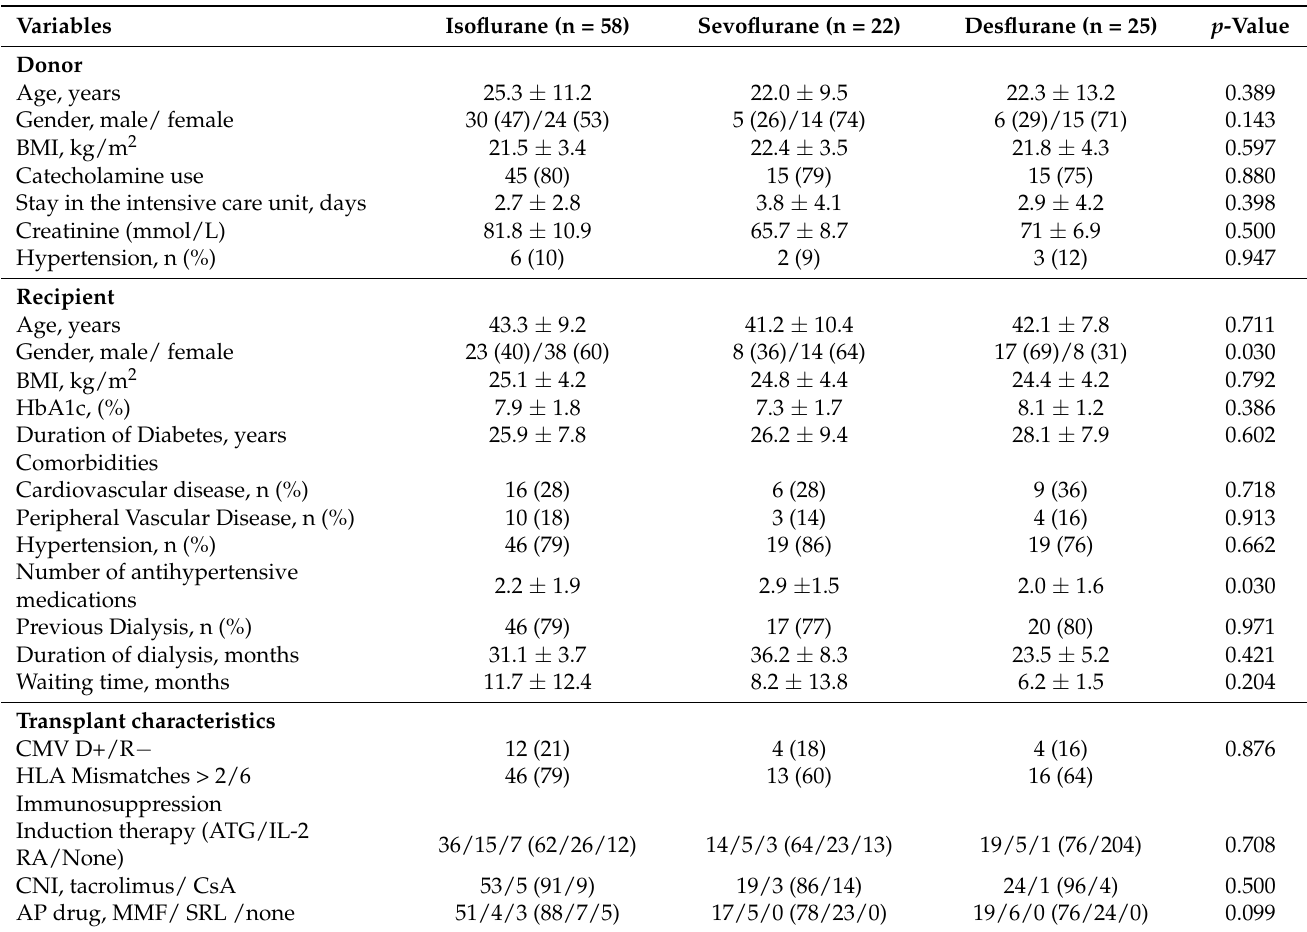
Table legends: BMI—body mass index; Hb1Ac—glycosylated hemoglobin; CMV—cytomegalovirus; HLA— human leukocyte antigen; ATG—antithymocyte globulin; IL-2 RA—interleukin-2 receptor antagonist;